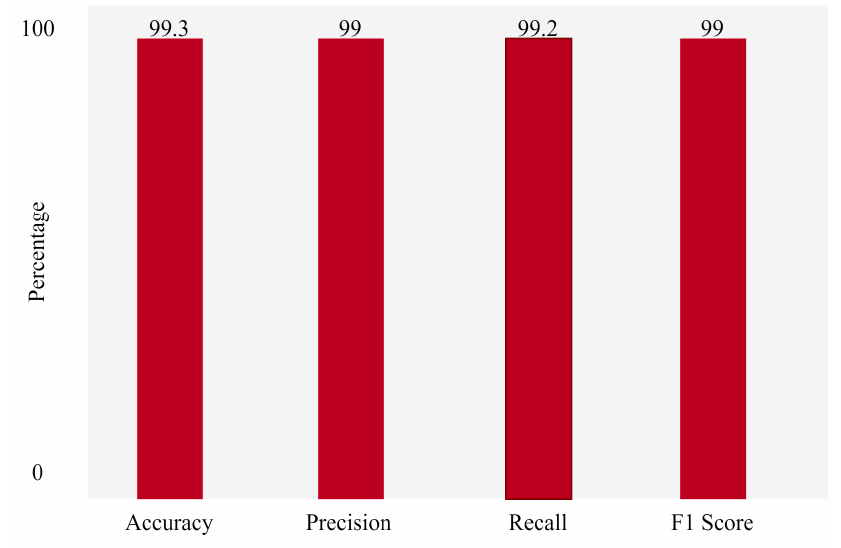
Figure 10. Evaluation of ENN on IoR with k-Means Clustering.